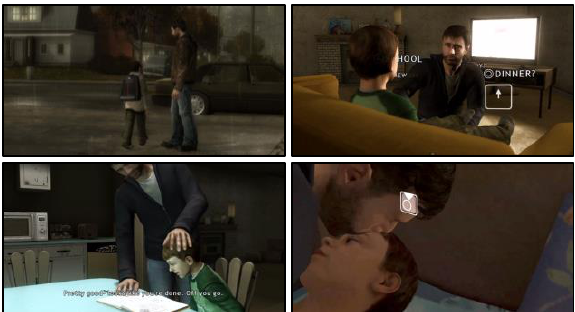
Figure 3 | ‘ Rupture’ is made of stress and focus. Pictures extracted from the ‘Chapter 2: The Mall’ of Heavy Rain .